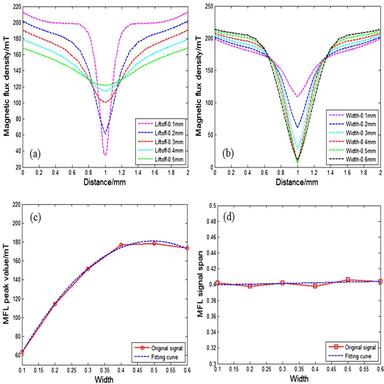
MFL signals and characterizations of rectangular defect; (a) MFL signals of rectangular defect in different liftoff values with the width of 0.2 mm; (b) MFL signals of rectangular defect in different widths with the liftoff of 0.2 mm; (c) Relationships between MFL peak values in (b) and rectangular defect widths; (d) Relationships between MFL signal spans in (b) and rectangular defect widths.